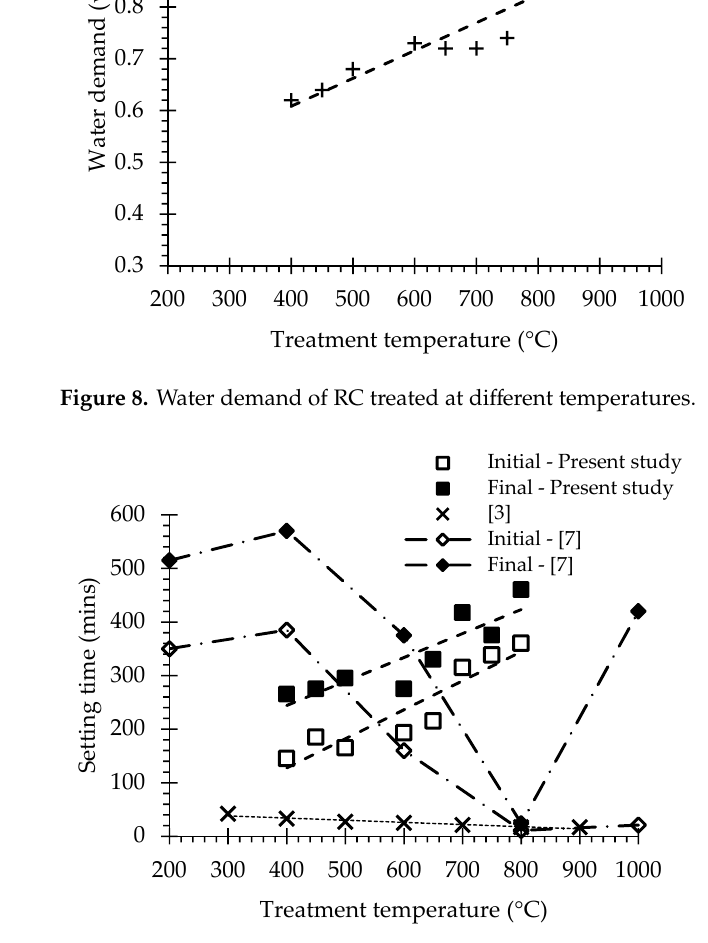
Figure 9. Setting time of RC treated at different temperatures. Values reported by other authors shown for comparison [4,8]. Table 5. Water demand and setting time of PC and RC, and flowability of the pastes.